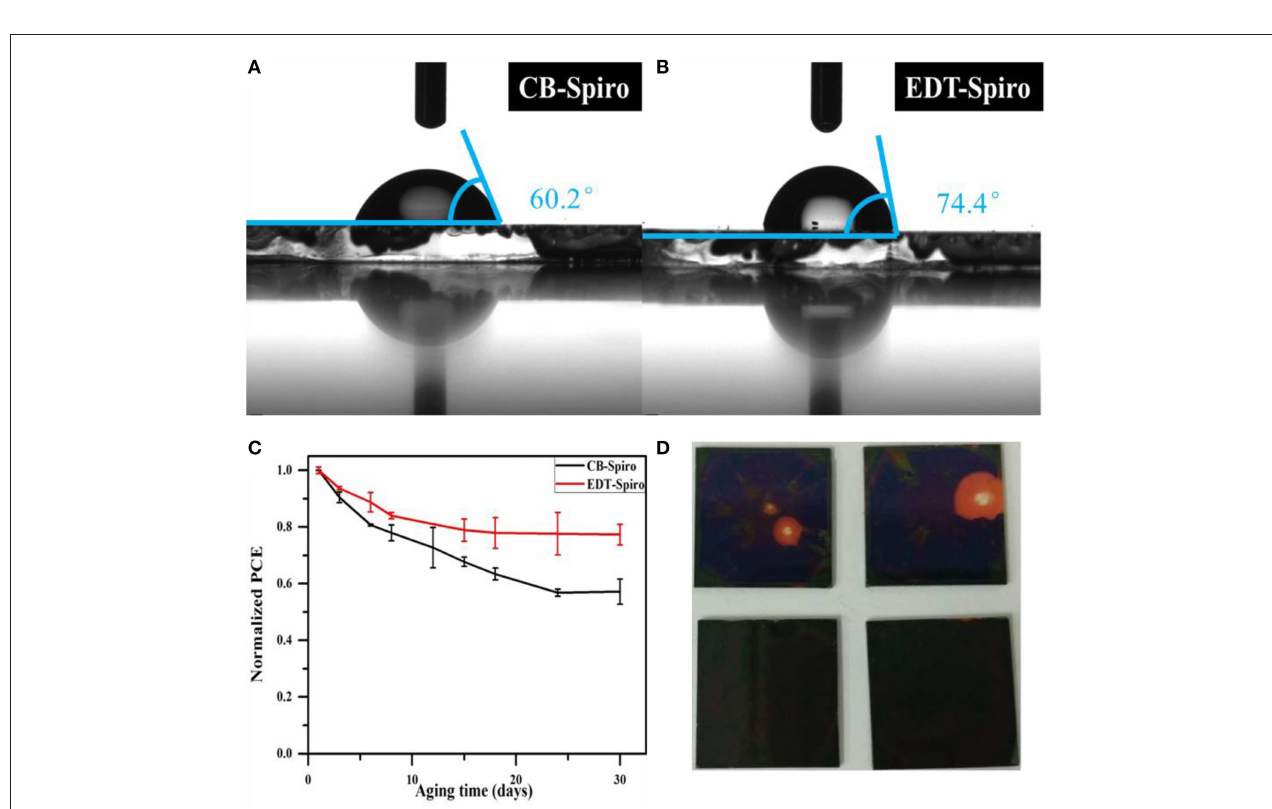
FIGURE 5 | (A) The water contact angles of CB-Spiro films and (B) EDT-Spiro films. (C) Stability test of the best CB and EDT devices under N 2 atmosphere without sealing. (D) Photos of CB-Spiro (the above one) and the EDT-Spiro (the below one) films upon in the O 2 atmosphere for 2 days.